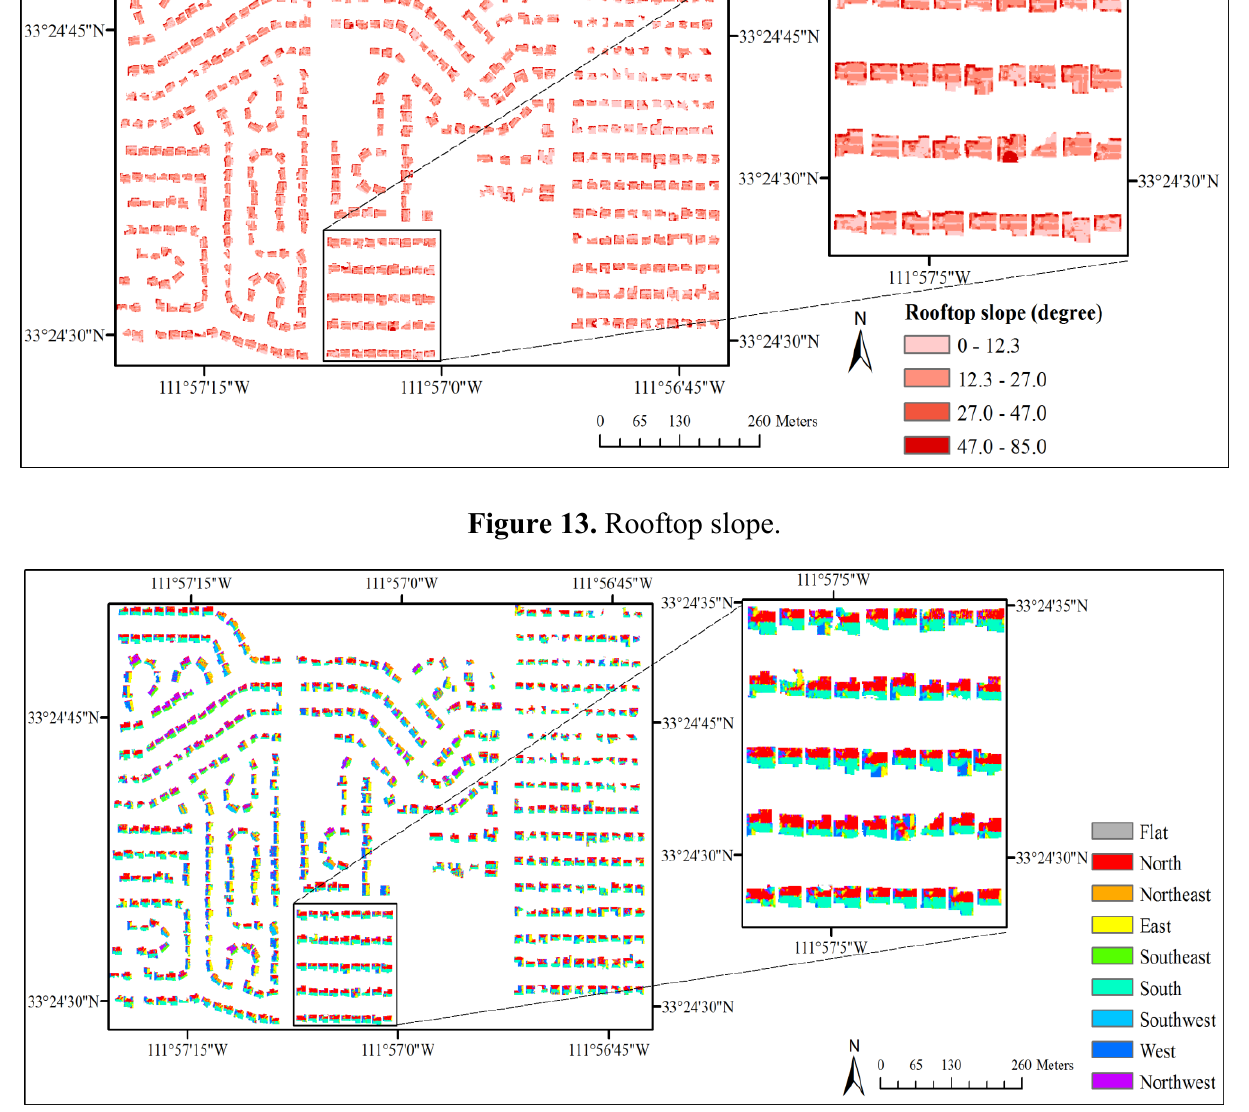
Figure 14. Rooftop